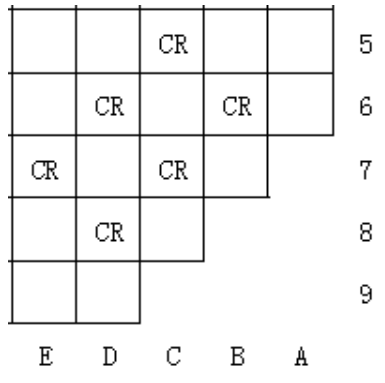
Figure 3. CR Loading Pattern of the Boron and CR Co-Controlled